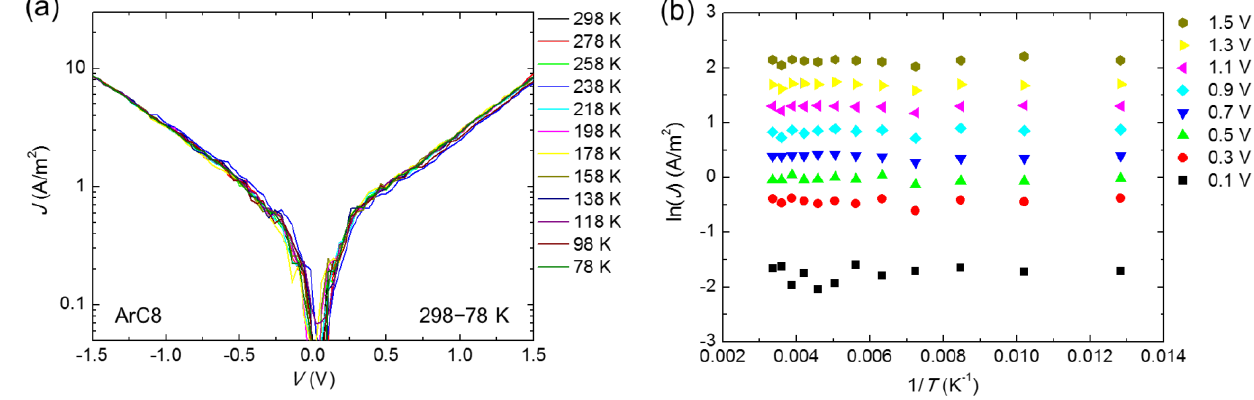
Figure 2. ( a ) Variable-temperature J – V characteristics with temperature variation from 298 to 78 K with 20 K steps, displayed in different color lines. ( b ) Arrhenius plot of ArC8 junctions at voltages from 0.1 to 1.5 V with 0.2 V steps.